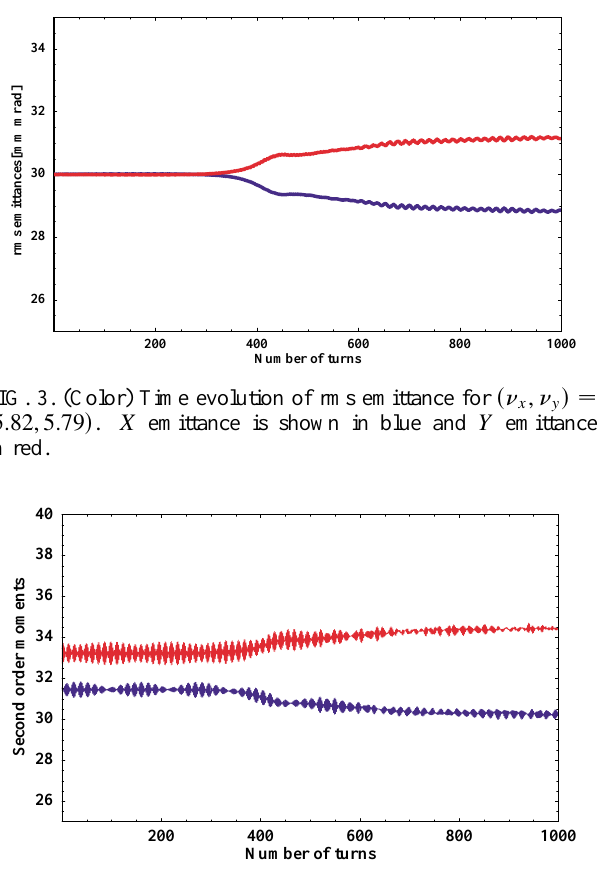
FIG. 4. (Color) Time evolution of (cid:5) x 2 (cid:6) (blue) and (cid:5) y 2 (cid:6) (red) for (cid:2) (cid:1) (cid:1) 5.82, 5.79 (cid:2) in normalized (cid:1) n x , n y